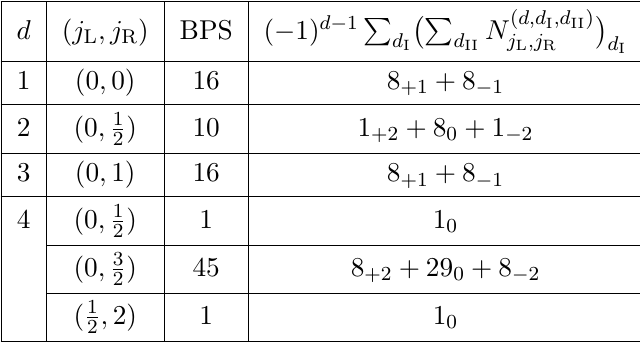
Table 1 . The split of the BPS indices on the D 5 del Pezzo curve for the (2 ; 2) model. The split is interpreted as the decomposition of the D 5 representations into the D 4 subalgebra, as in 16 ! ( 8 ) +1 + ( 8 ) (cid:0) 1 , 10 ! ( 1 ) +2 + ( 8 v ) 0 + ( 1 ) (cid:0) 2 and 45 ! ( 8 v ) +2 + ( 28 ) 0 + ( 1 ) 0 + ( 8 v ) (cid:0) 2 s = c s = c